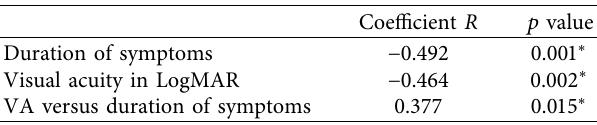
Figure 2: Schematic diagrams showing summary of the characteristics of (a) FAF and (b) OCTimaging changes in different stages of CSC. White arrows indicate the leakage site on the FAF images. Table 3: Correlation analysis of photoreceptor (IS/OS) length, with the duration of symptoms and the visual